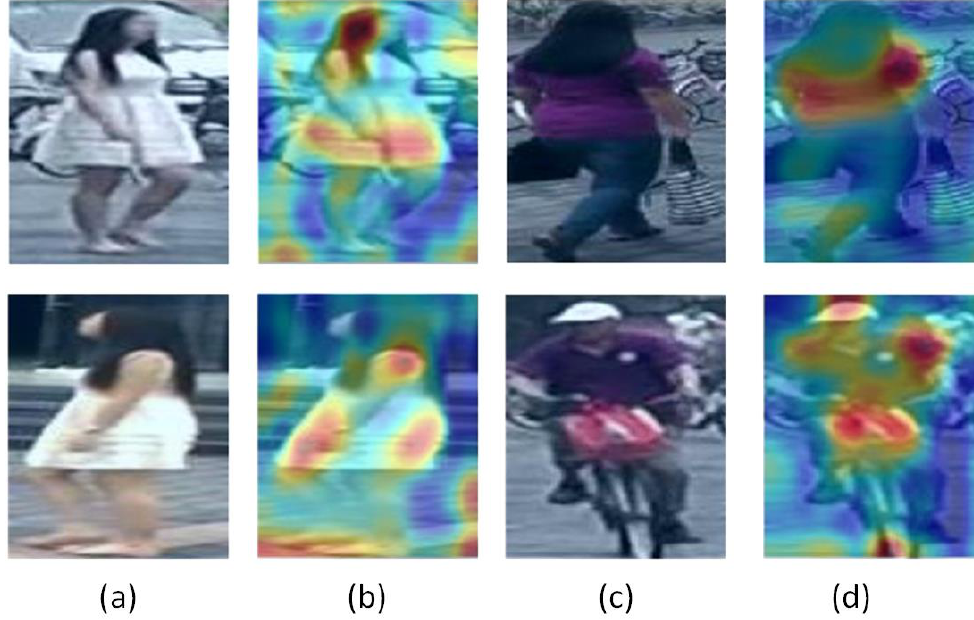
Figure 5. Two examples to show the effectiveness of the local body part features: ( a ) two images of the same person; ( b ) corresponding feature maps of ( a ); ( c ) two different persons; and ( d ) corresponding feature maps of ( c